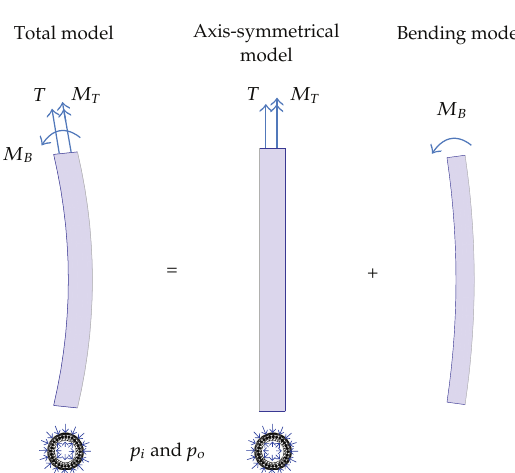
Figure 3: Response models for cross-sectional